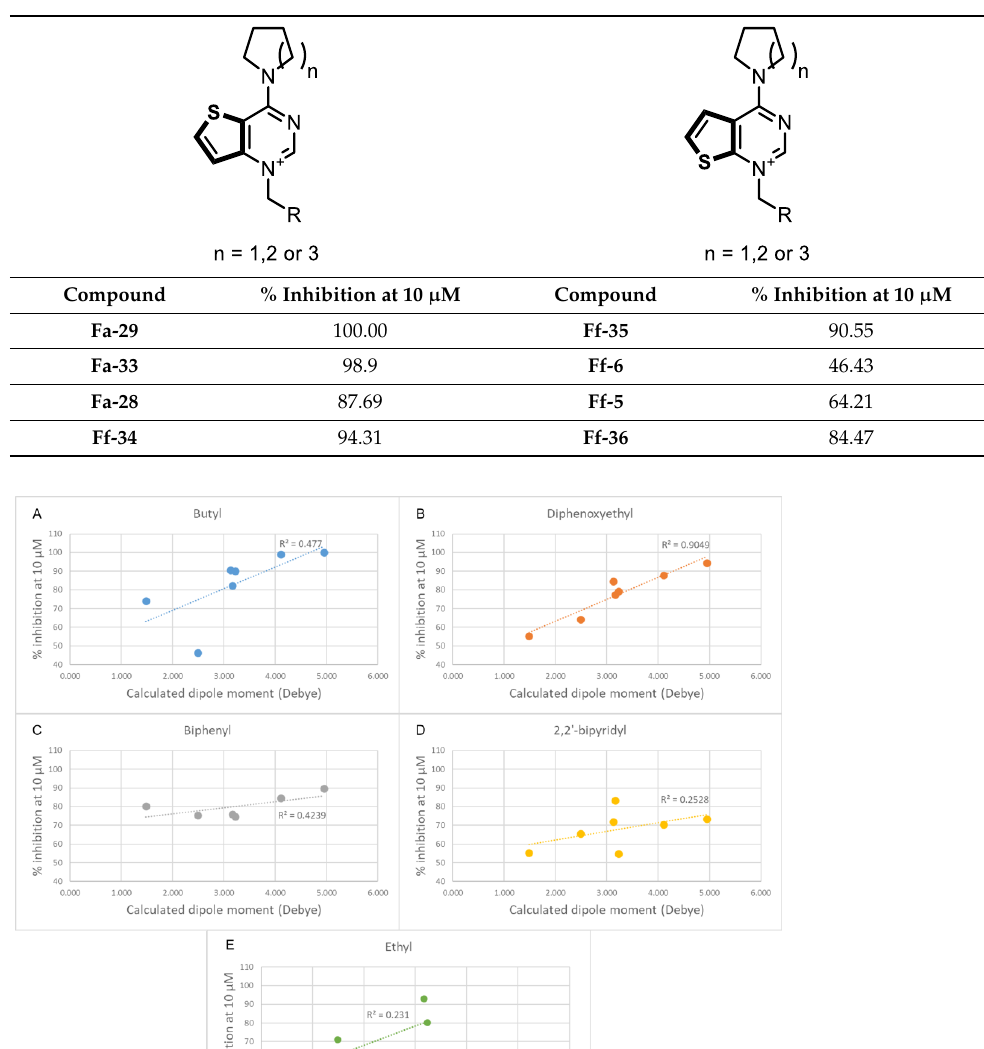
Table 3. Selected examples of the reduction in the inhibitory potency in the thieno[2,3-d]pyrimidinium heads if compared to the thieno[3,2-d]pyrimidinium ones.